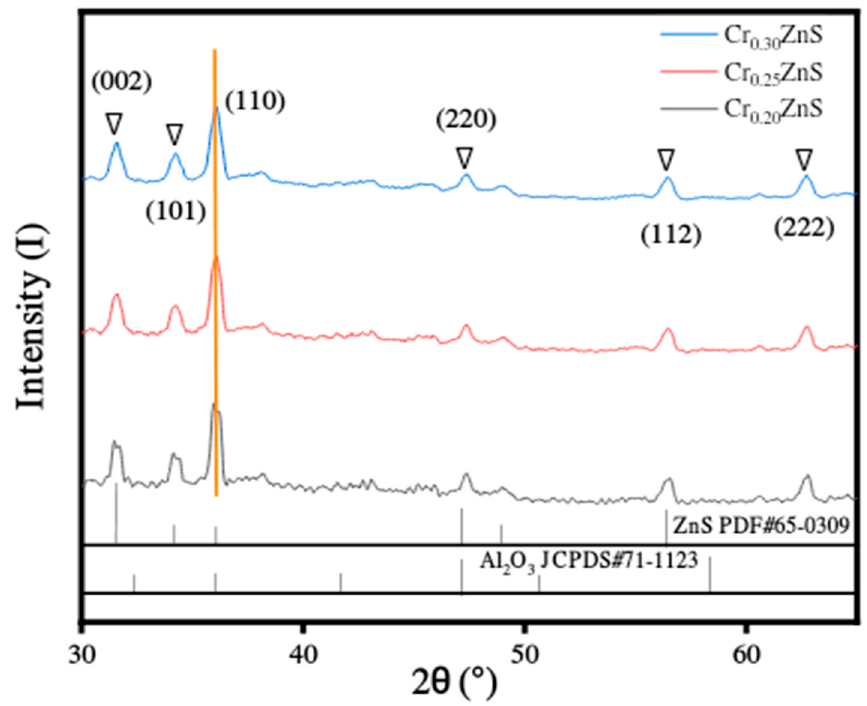
Figure 6. XRD spectra of the Cr x ZnS (x = 0.20, 0.25, and 0.30)